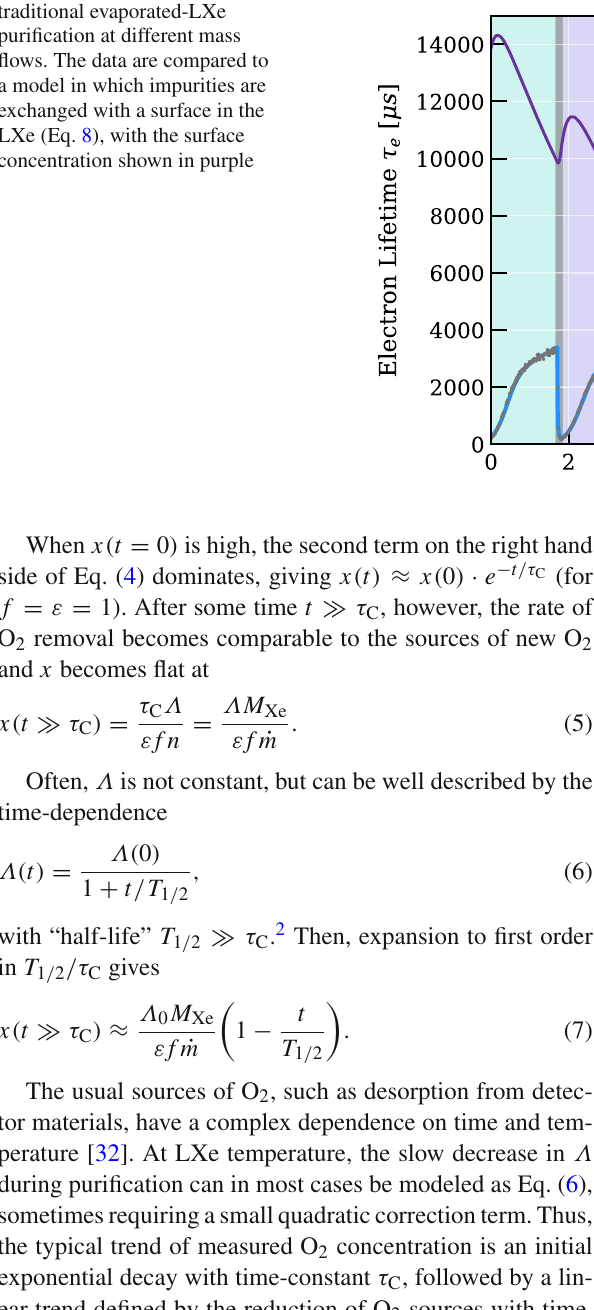
Fig. 4 PM data from test of traditional evaporated-LXe purification at different mass flows. The data are compared to a model in which impurities are exchanged with a surface in the LXe (Eq. 8), with the surface concentration shown in purple